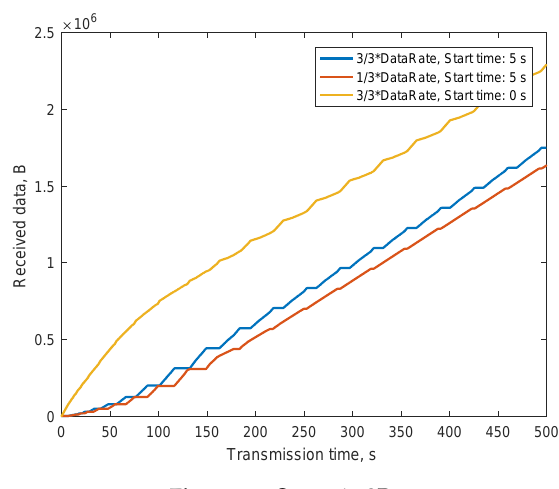
Figure 16. Scenario 2B.